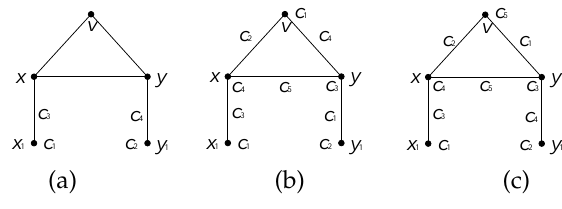
Figure 1. A graph and its certain